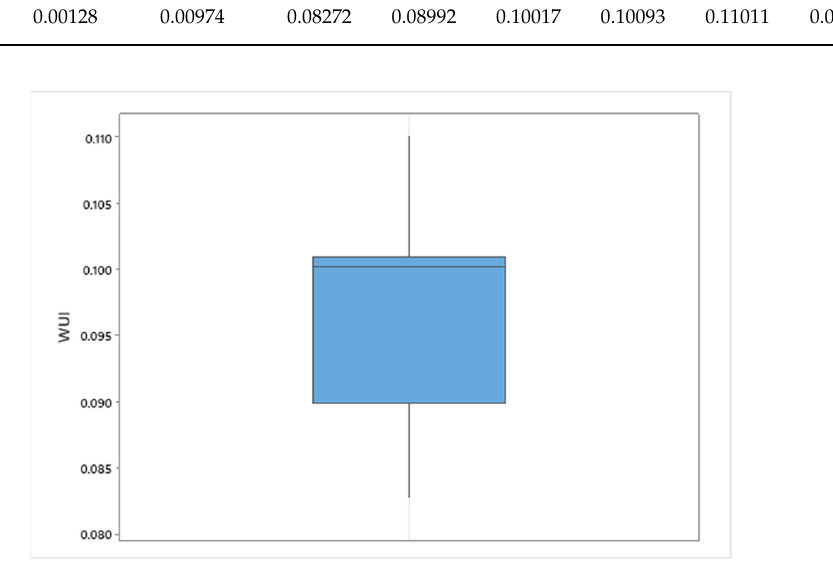
Figure A6. Normalized water box-plot for any building.